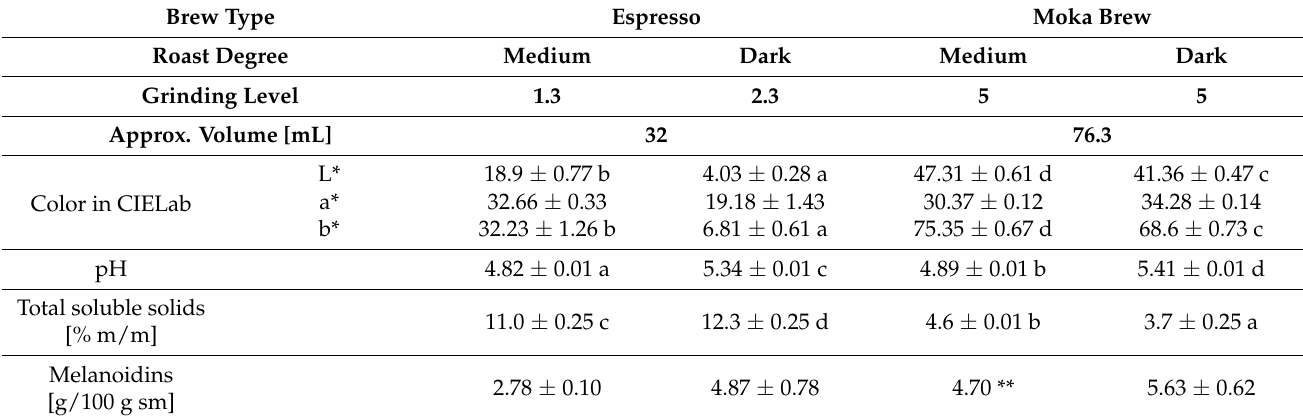
Table 2. Characteristics of coffee